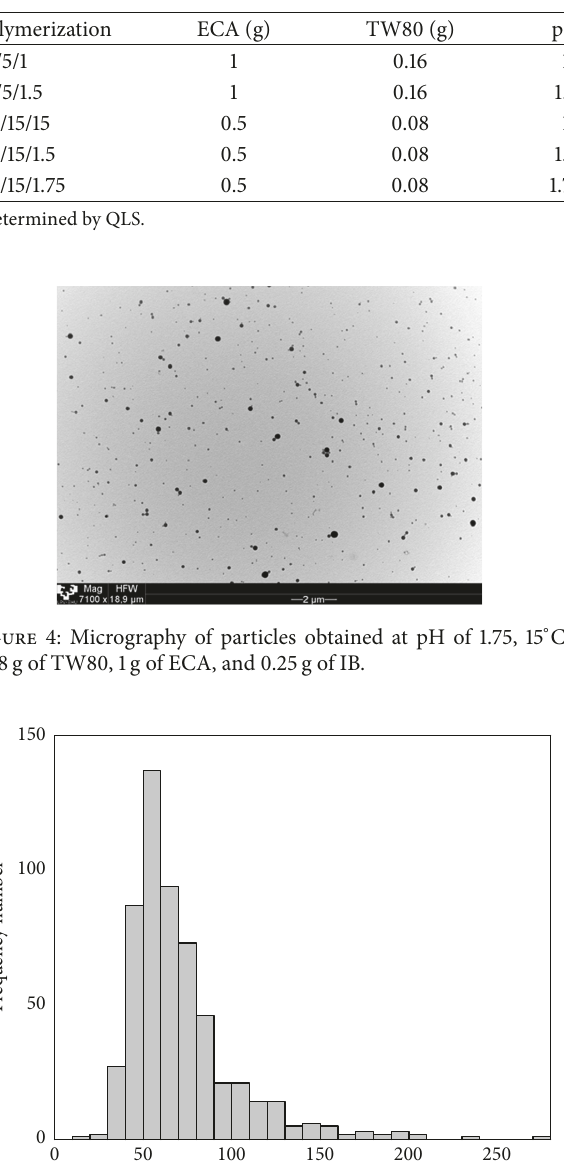
Table 1: Average particle size and IB content of the nanoparticles.